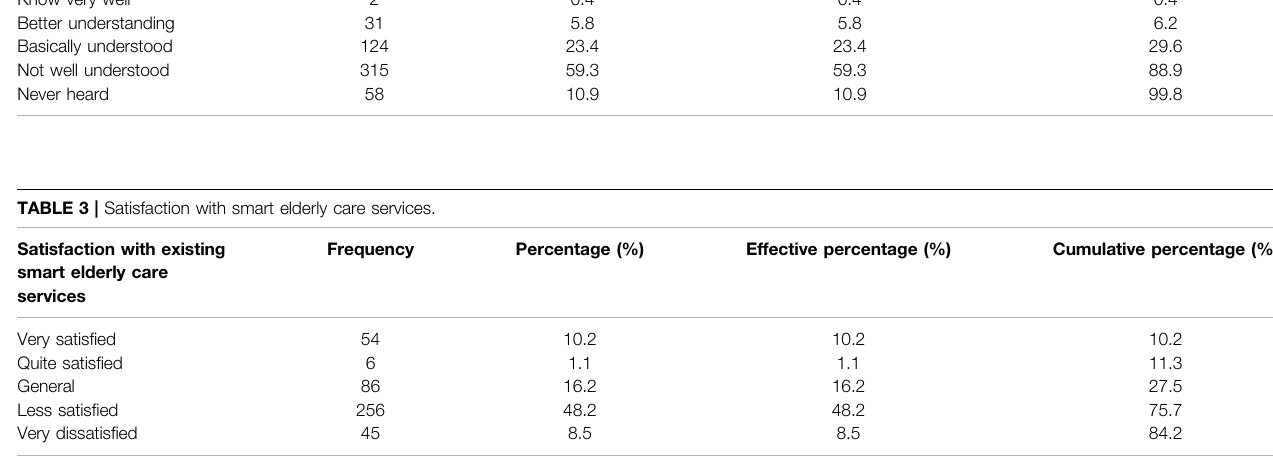
TABLE 2 | Degree of understanding of intelligent elderly care services. Understanding of existing smart elderly care services